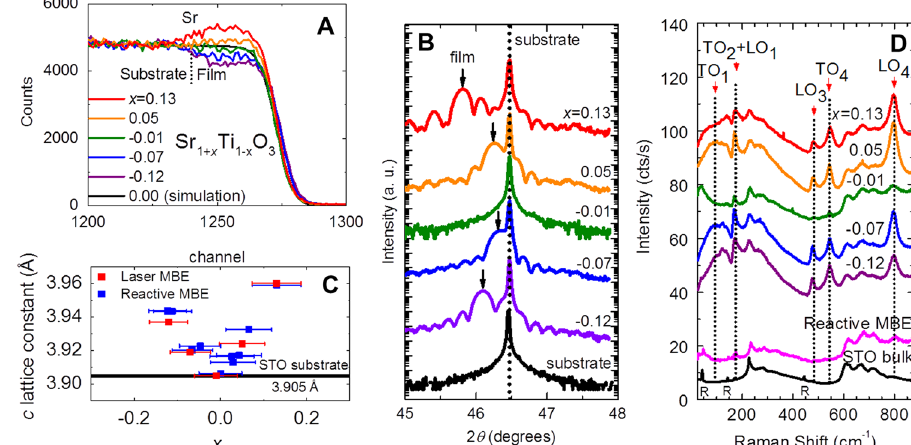
Fig. 2 a RBS spectra for fi ve 60 nm thick Sr 1+ x Ti 1- x O 3+ δ fi lms grown by ALL-Laser MBE on SrTiO 3 substrates. The compositions determined by RBS have an error of ± 5%. b XRD θ -2 θ scans of the fi lms and a bare SrTiO 3 substrate. The black dotted line represents the substrate peak position, and arrows point to fi lm peaks. c The c lattice constant (determined by the XRD measurement) vs. x (determined by the RBS measurement) for the fi ve fi lms. The data from fi lms grown by reactive MBE are included for comparison. d Ultraviolet Raman spectra ( λ = 325 nm, T = 10 K) for the fi ve fi lms, a stoichiometric fi lm grown by reactive MBE, and a SrTiO 3 single